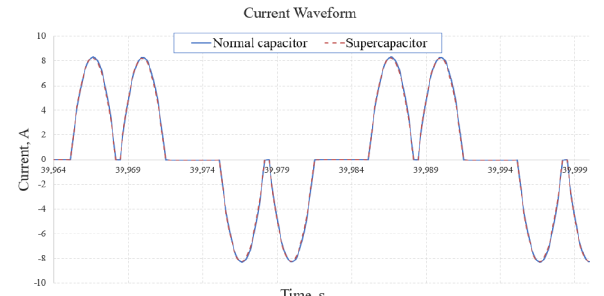
Figure 2. Current waveform on the input of frequency converter